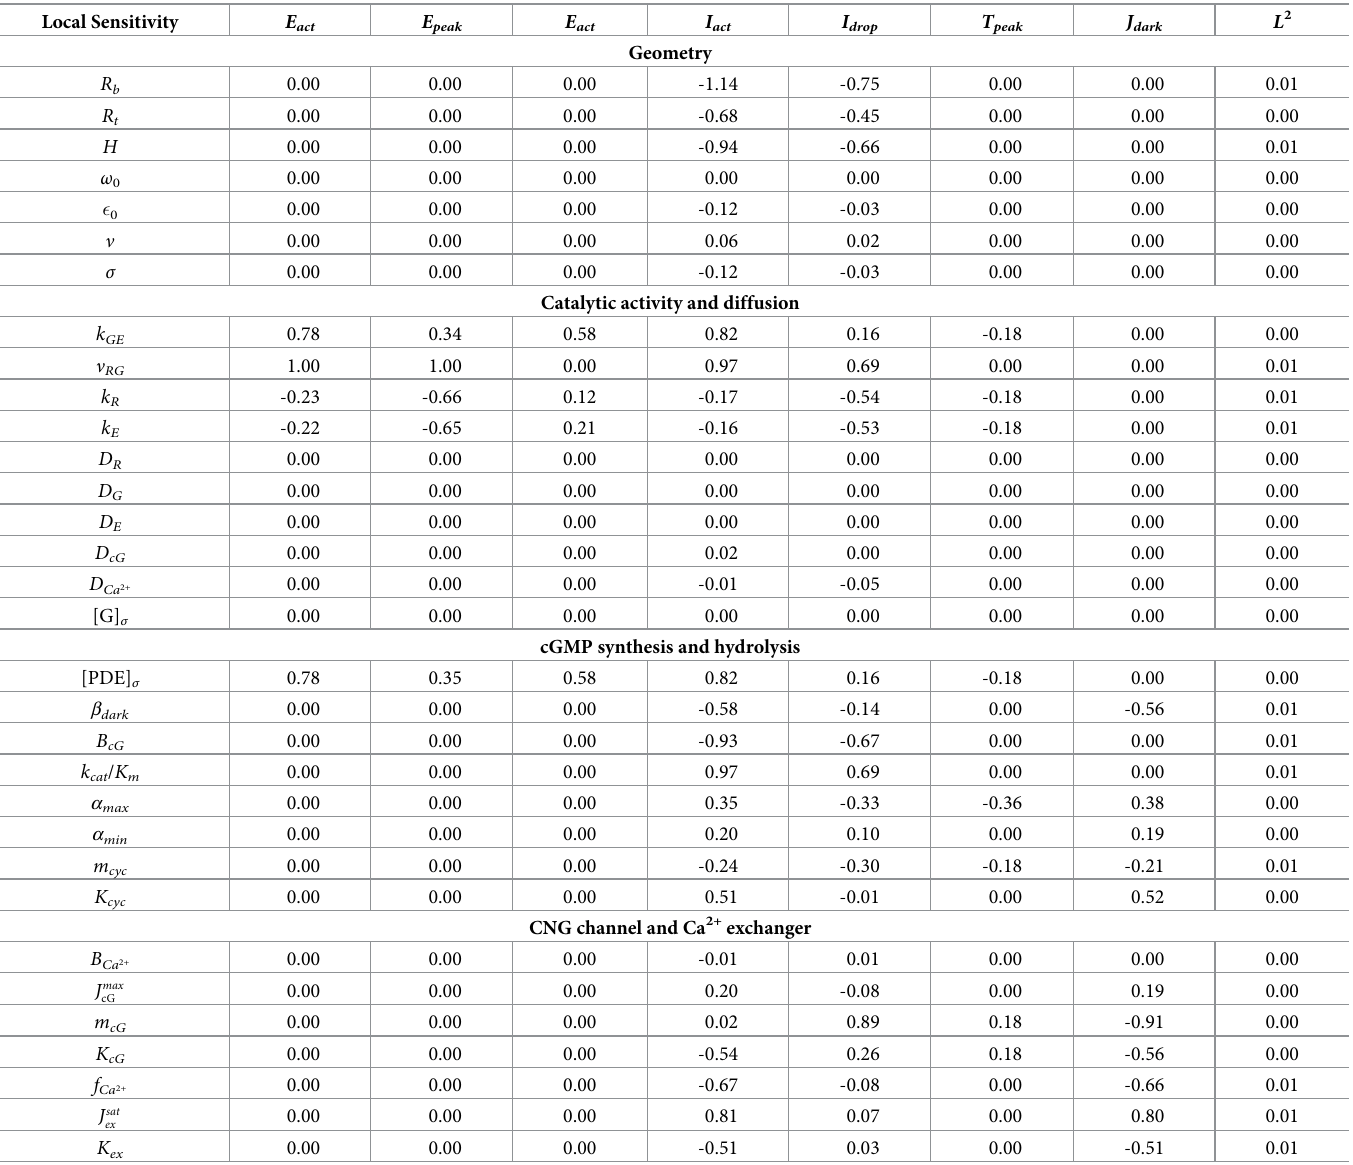
Table 11. Local sensitivity indices for a flash of 940 isomerizations uniformly distributed throughout the outer segment. Local